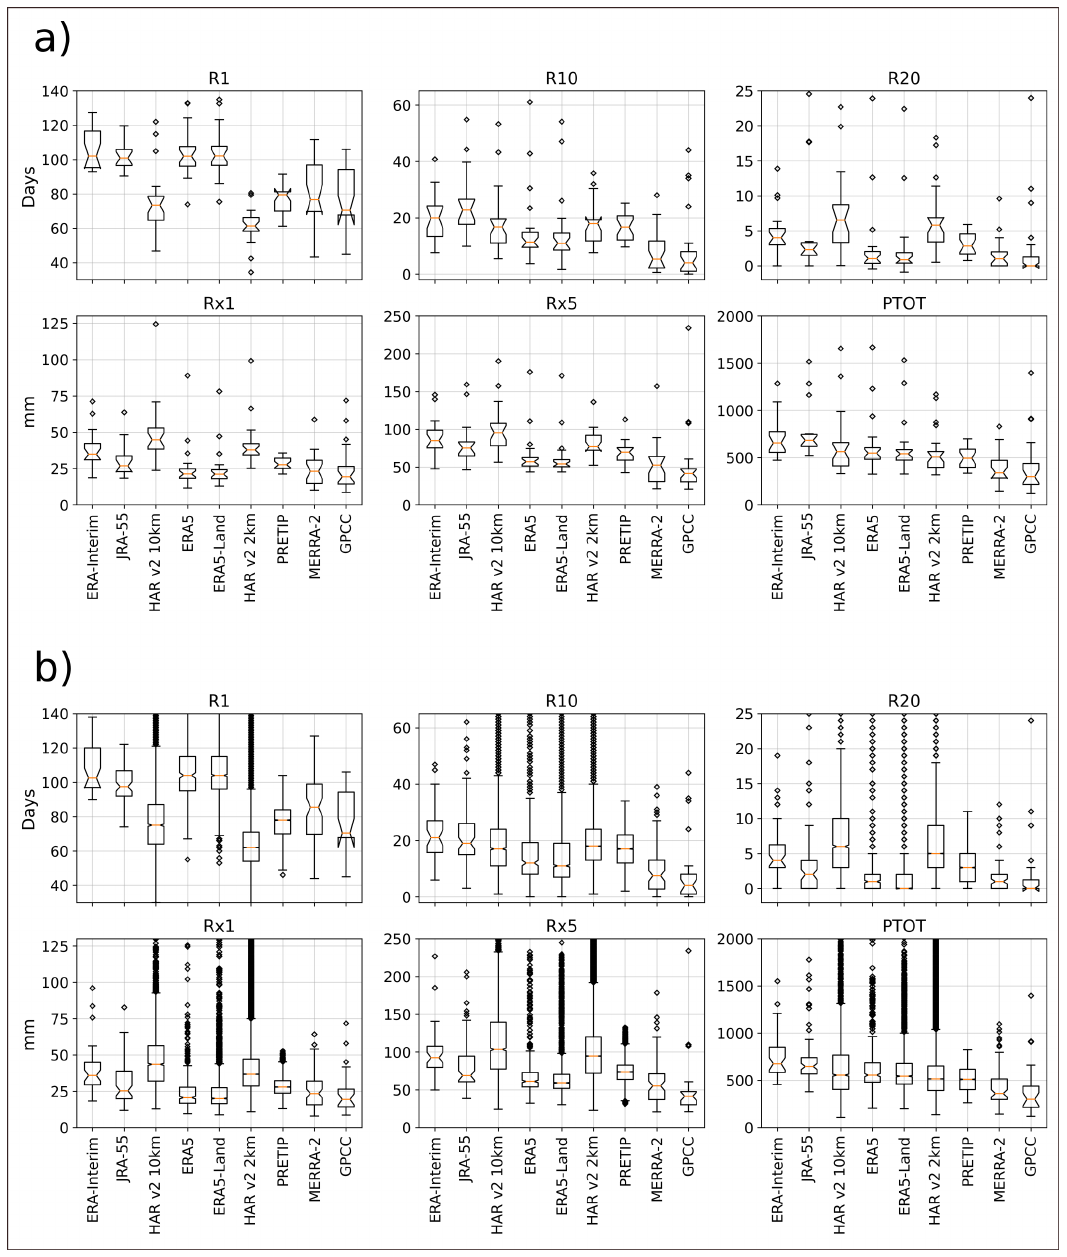
Figure A2. Visualization of the selected climdex indices R1, R10, R20, Rx1, Rx5 and PTOT as boxplot charts equivalent to Figure 8 (for description see Table 3). ( a ) depicts resulting values after resampling every product to the grid resolution of the lowest resolved product. ( b ) shows the same boxplot charts as Figure 8, but with the y-axis limits adjusted to the range in (a) to allow for direct comparison between both